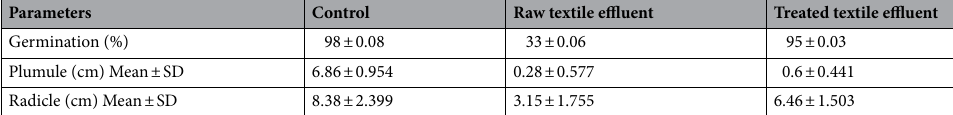
Table 2. Phytotoxicity study of untreated and treated textile effluent on P. mungo . Values are mean of three experiments, SD ( ±), significantly different from the control (seeds germinated in water) at P > 0.05 (One-way analysis of variance, ANOVA).